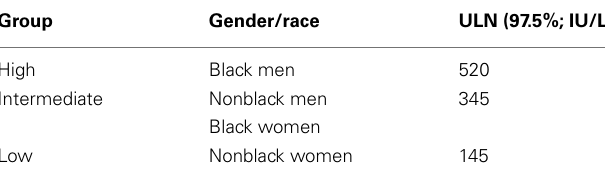
Table 8 | Effect of race and gender on creatine kinase measurements.